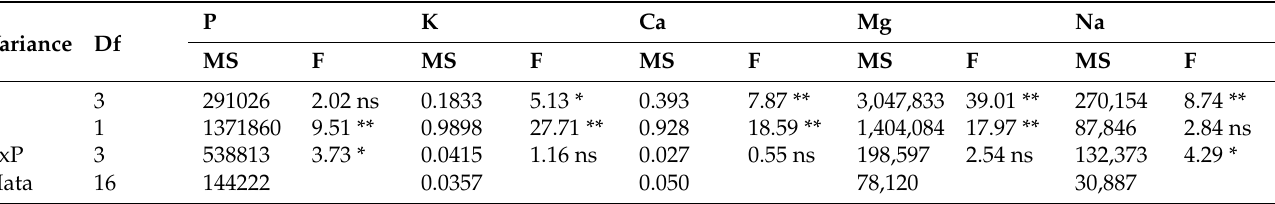
Table 6. Variance analysis table for the effects of biochar and PGPR applications on iron (Fe), manganese (Mn), zinc (Zn) and copper (Cu) nutrients, and lead (Pb) and nickel (Ni) heavy metal contents of Siyez wheat. Variance